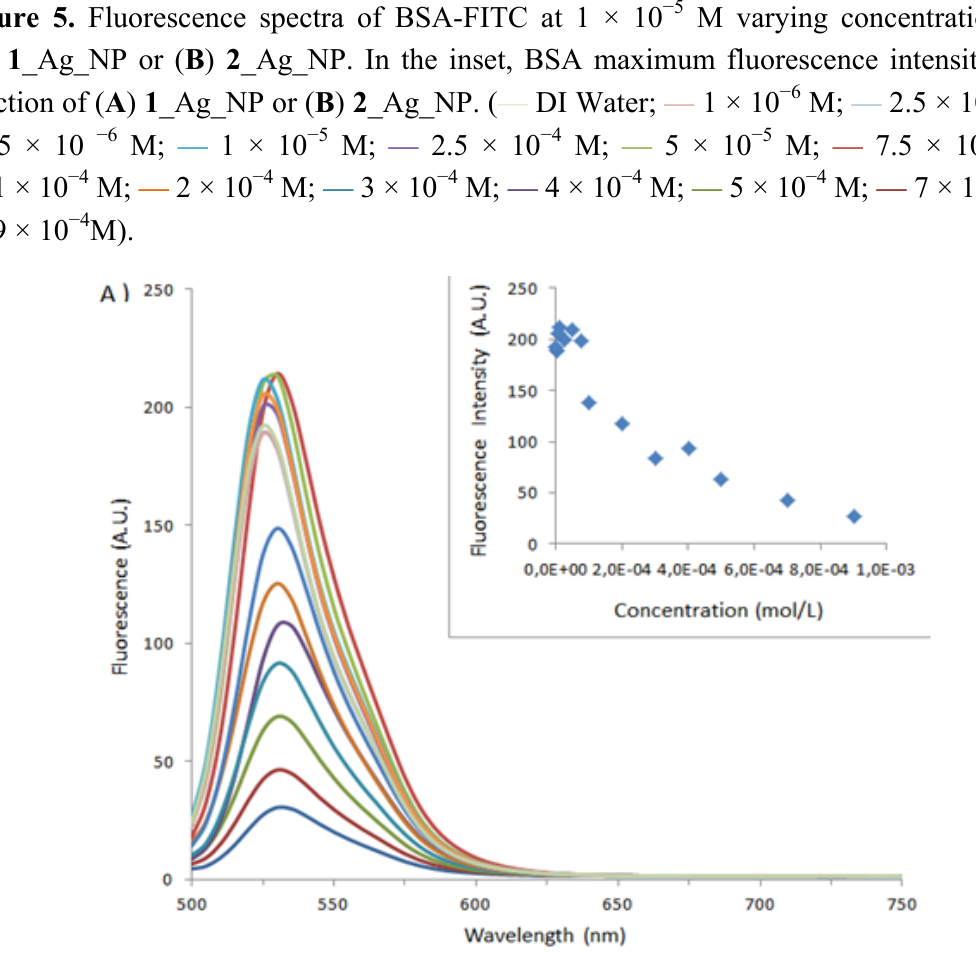
Figure 5. Fluorescence spectra of BSA-FITC at 1 × 10 − 5 M varying concentrations of ( A ) 1 _Ag_NP or ( B ) 2 _Ag_NP. In the inset, BSA maximum fluorescence intensity as a function of ( A ) 1 _Ag_NP or ( B ) 2 _Ag_NP. (— DI Water; — 1 × 10 − 6 M; — 2.5 × 10 − 6 M; — 5 × 10 − 6 M; — 1 × 10 − 5 M; — 2.5 × 10 − 4 M; — 5 × 10 − 5 M; — 7.5 × 10 − 5 M; — 1 × 10 − 4 M; — 2 × 10 − 4 M; — 3 × 10 − 4 M; — 4 × 10 − 4 M; — 5 × 10 − 4 M; — 7 × 10 − 4 M; — 9 × 10 − 4